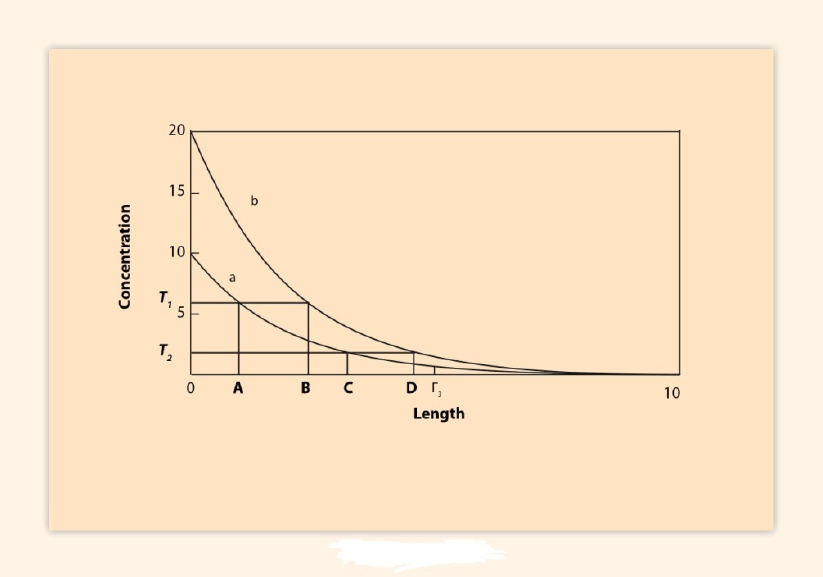
Figure 3. Variable diffusion gradients in arbitrary units of length and concentration. (Adapted from S. Papageorgiou, J Theor Biol.; 1998, 192: 43–53). At the origin x = 0, theconcentrations are 10 and 20 for the curves ( a ) and ( b ), respectively. For every point x, b(x) = 2a(x). This relation is true for any time t (0 ≤ t ≤ t (asymptotic).